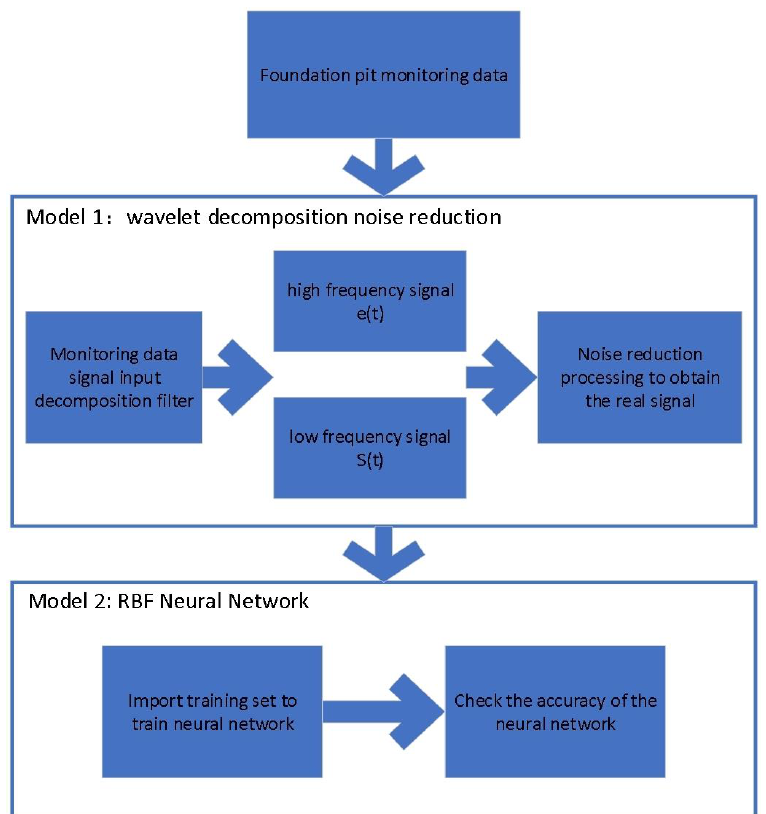
Figure 2. W-RBF forecasting flowchart.